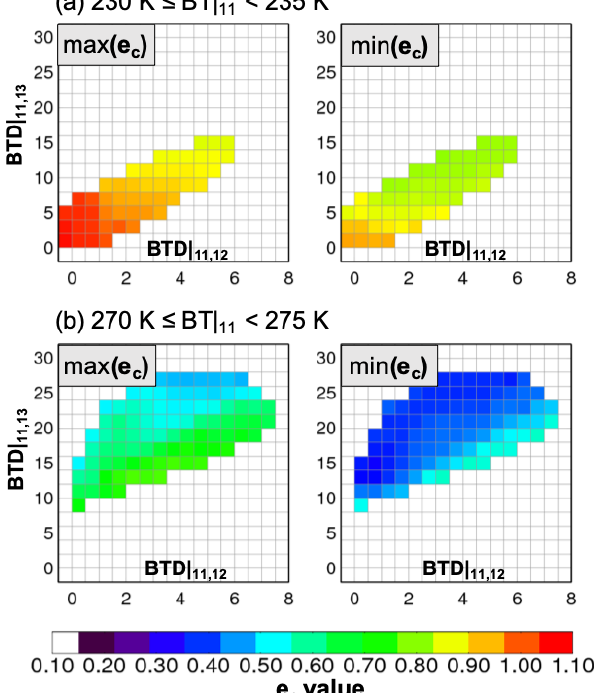
Figure 4. Look-up table values for min–max( e c ) (left and right pan- els in colors) by BTD | 11 , 12 ( x axis) and BTD | 11 , 13 ( y axis) for (a) 230K ≤ BT | 11 <235K and (b) 270K ≤ BT | 11 <275K. For this